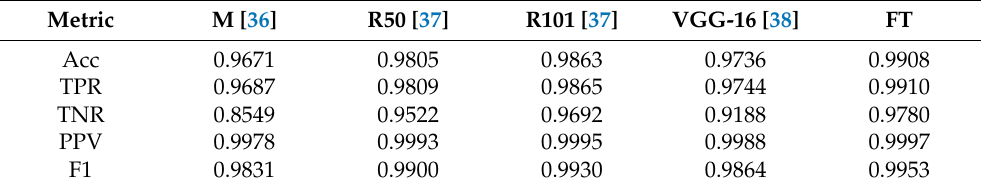
Figure 5. Incremental classification performance in terms of the top-1 accuracy on the com- bined dataset. Table 10. Performance comparison on the combined dataset. Even with cross-domain classes, the proposed model achieved comparable performance to the fine-tuned model while requiring fewer resources.